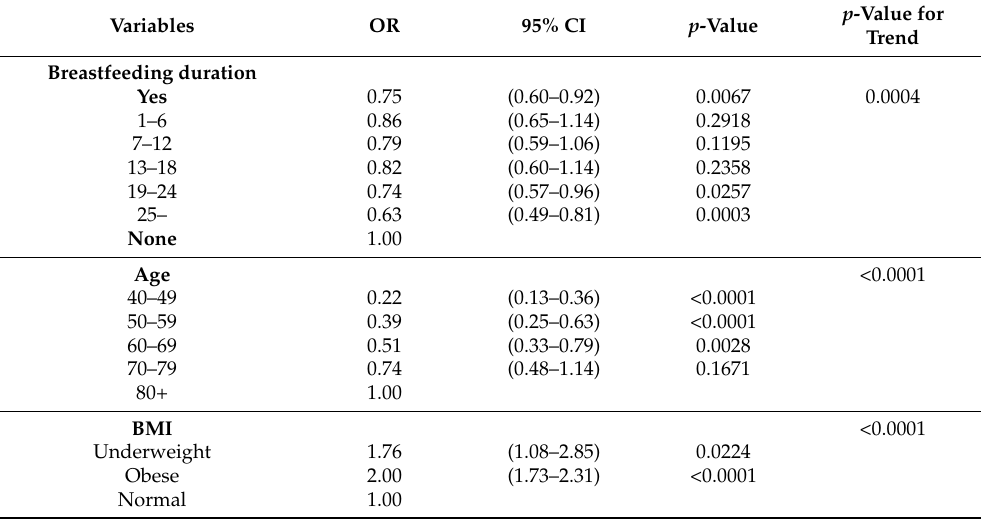
Table 2. Association of restrictive spirometric pattern according to breastfeeding or duration of